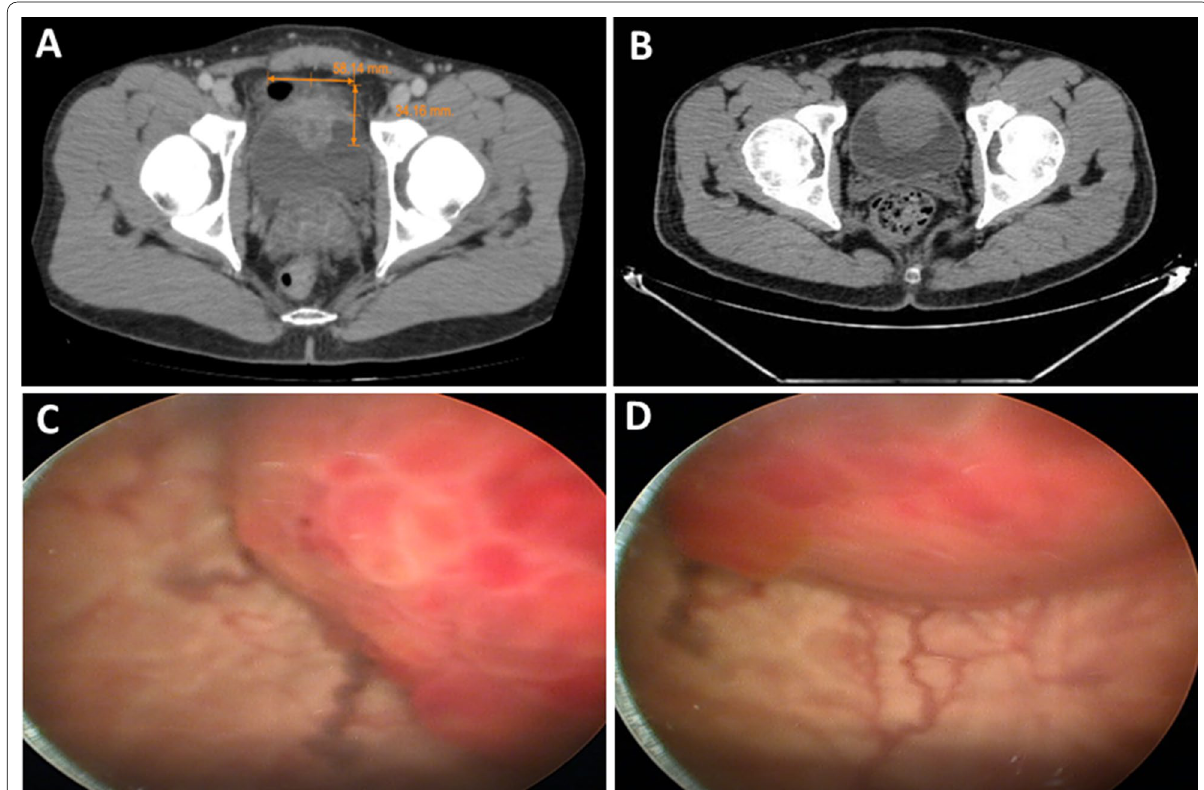
Fig. 1 BIMT figures: a , b Cross-sectional view of the CT scans of patients diagnosed with bladder MIT. c , d Cystoscopic